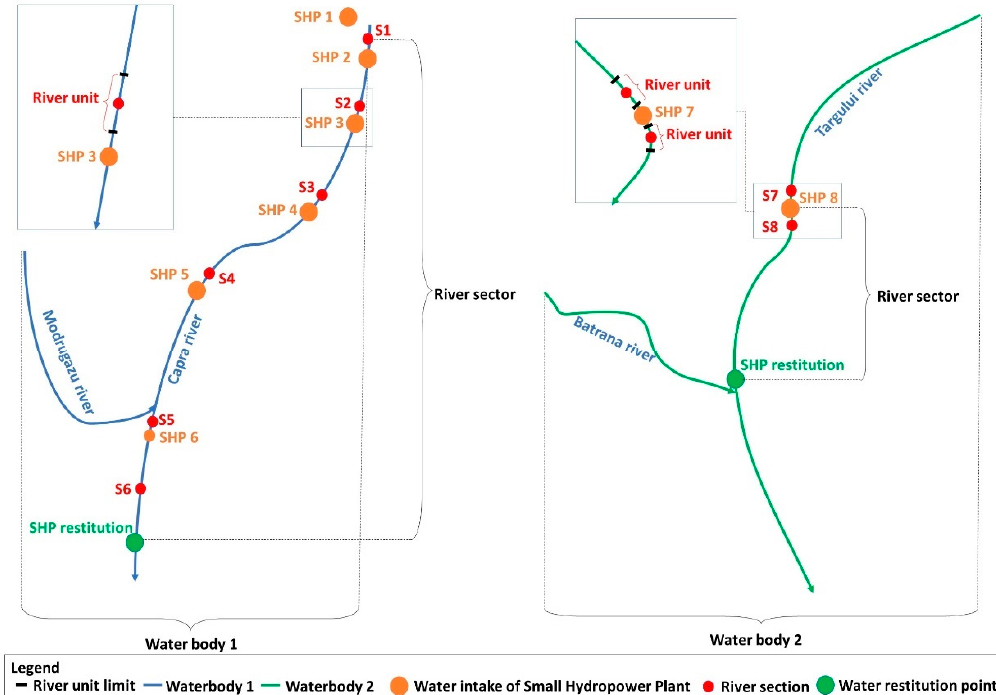
Figure 3. The schematic representation of the river unit, characteristic river cross-sections and the river sector for hydromorphological measurements in the case of the analyzed water bodies.